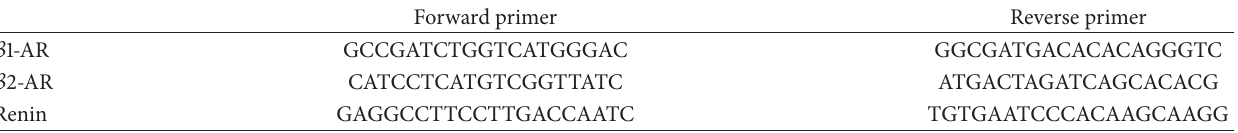
Table 1: Sequence for the primers and TaqMan probes for the rat 𝛽 1-AR, 𝛽 2-AR, and